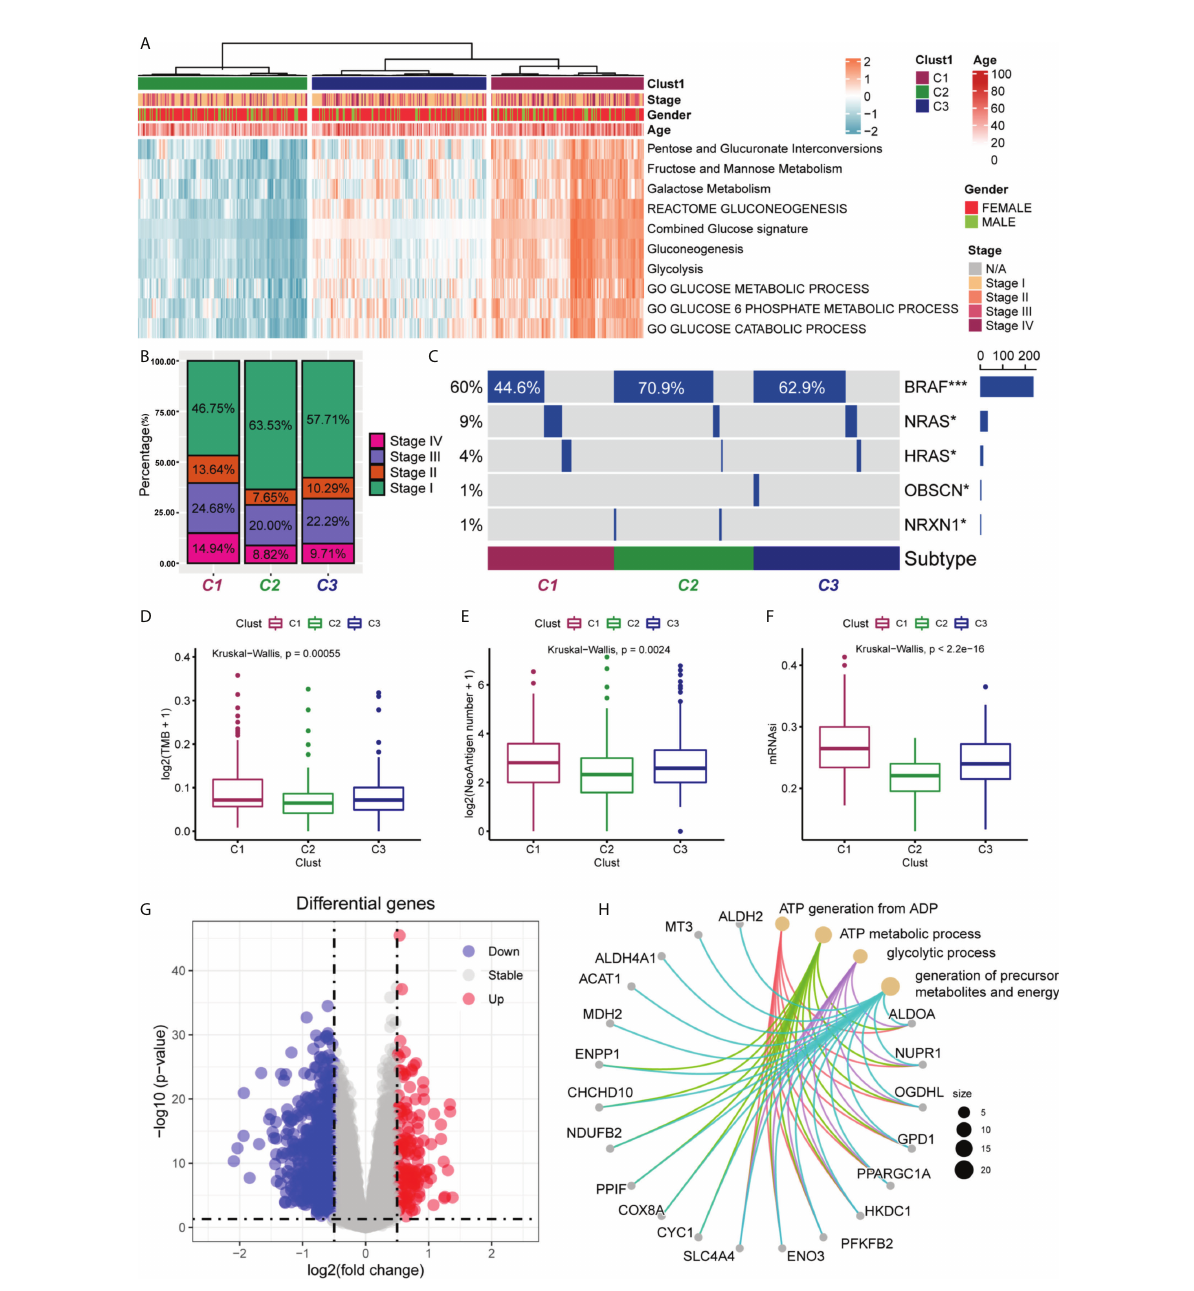
FIGURE 1 Clinical characteristics of PTC subgroups in TCGA. (A) Correlation of the subgroups of PTC patients (C1, C2 and C3) in the TCGA cohort with the 10 glucose metabolism-related pathways and the clinical characteristics of the patients. (B) Proportional distribution of the different pathological stages (stage I, II, III and IV) of PTC patients in the three subgroups. (C) Oncoprint of the mutational status of the three PTC subgroups. The frequency of NRAS and HRAS mutations were signi fi cantly higher in C1 subgroup than in C2 and C3 subgroups. The frequency of classical BRAF mutations was signi fi cantly higher in C2 and C3 subgroups than in C1 subgroup. *P < 0.05, ***P < 0.001. Differences in tumour mutation burden (TMB) (D) , number of neoantigens (E) and mRNA stemness index (mRNAsi) (F) among the three PTC subgroups. TMB, neoantigens and mRNAsi were all higher in C1 subgroup than in C2 and C3 subgroups. Statistical differences were compared by the Wilcoxon rank sum test. (G) Volcano plot of differentially expressed genes (DEGs) between the C1 and C2 subgroups. A total of 152 DEGs were screened (log2-fold change > 0.5, P < 0.05). (H) Enrichment analysis of the 20 most signi fi cantly upregulated